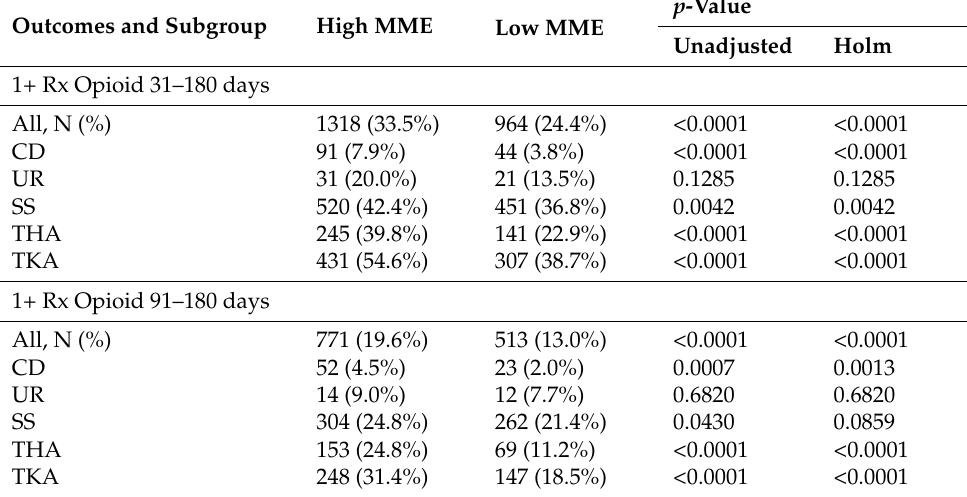
Table 2. Frequency and proportion of persistent opioid use: receiving 1+ opioid prescription between